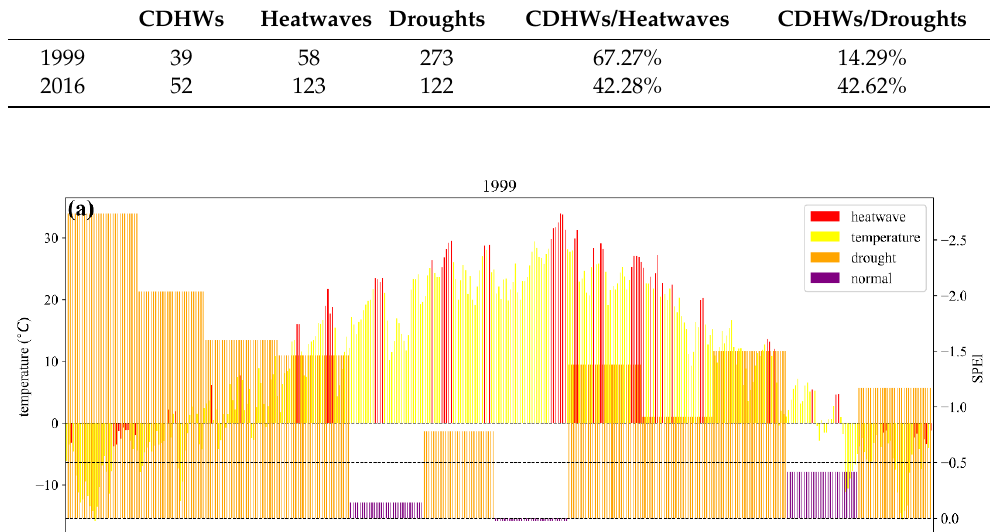
Table 2. Occurrences and proportions of droughts, heatwaves, and CDHWs.